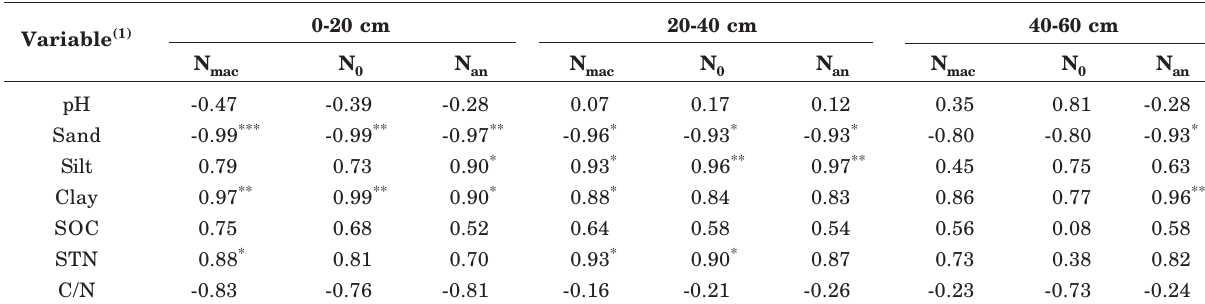
Table 4. Correlation coefficients (R) between soil properties and the following indexes: accumulated under anaerobic incubation (N an